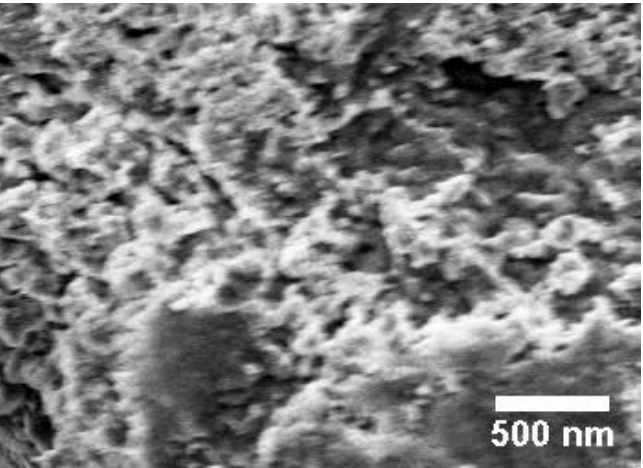
Figure 3. Field emission scanning electron microscopy ( FESEM) image of ZnFe 2 O 4 NPs.